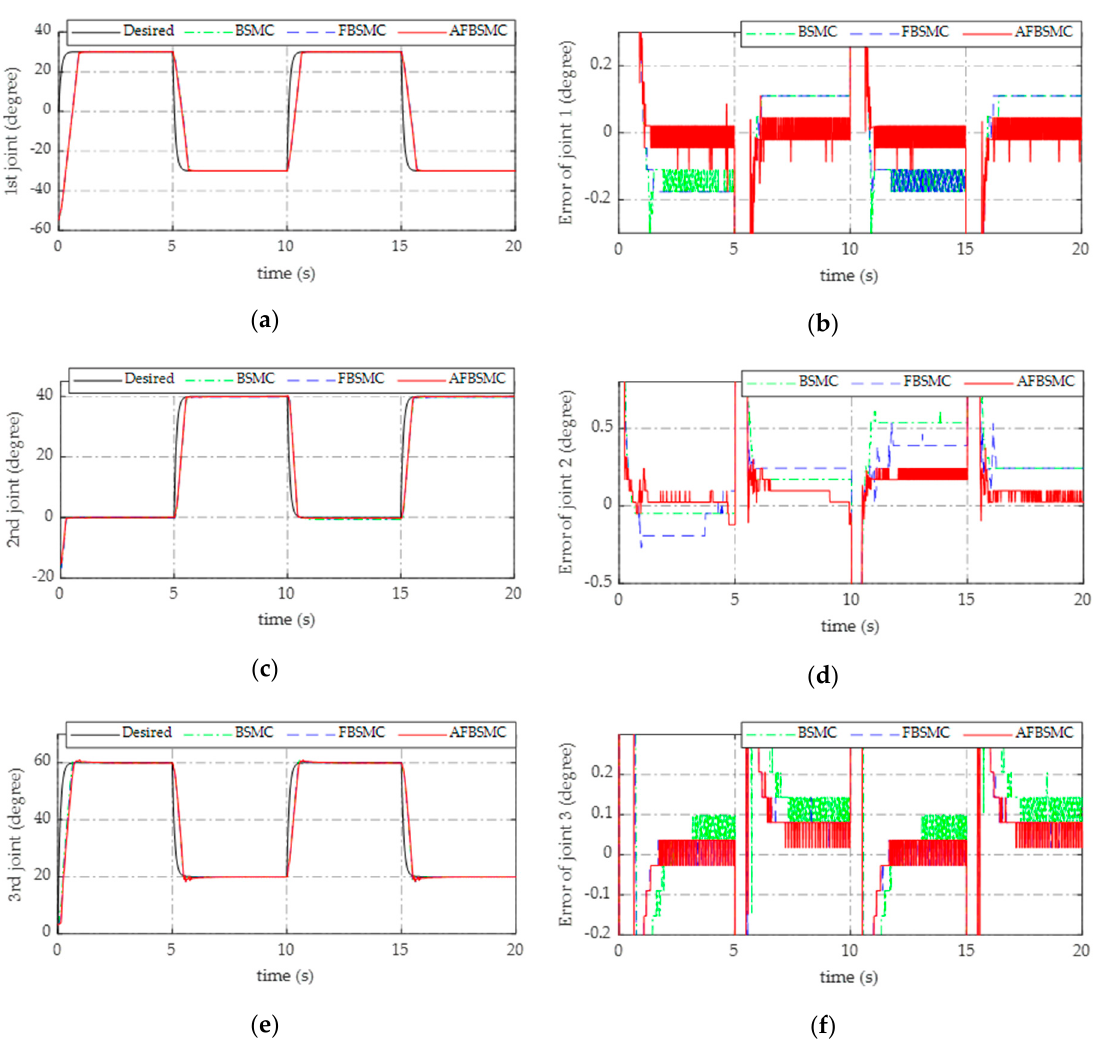
Figure 24. The tracking performance of the three joints in case of pulse signal with load: ( a ) The first joint and ( b ) its error; ( c ) the second joint and ( d ) its error; ( e ) the third joint and ( f ) its error in comparison between BSMC and FBSMC and AFBSMC.